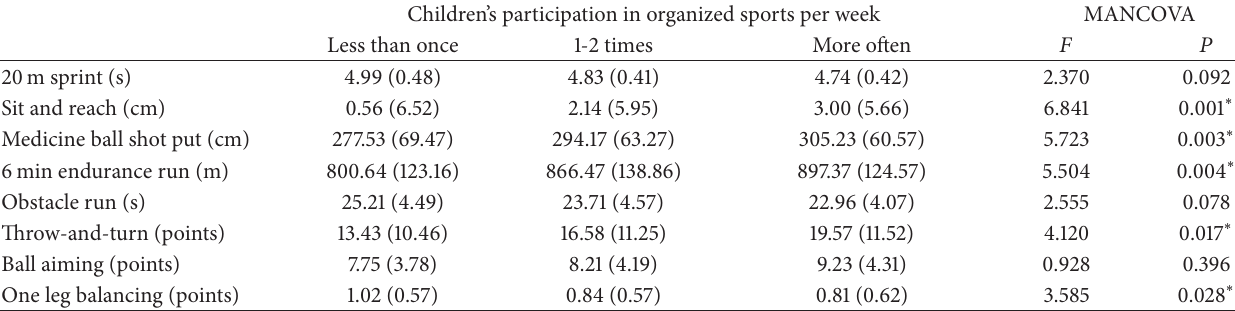
Table 4: Mean values and SD for individual fitness tests by participation in organized sports. 𝐹 and 𝑃 values are from